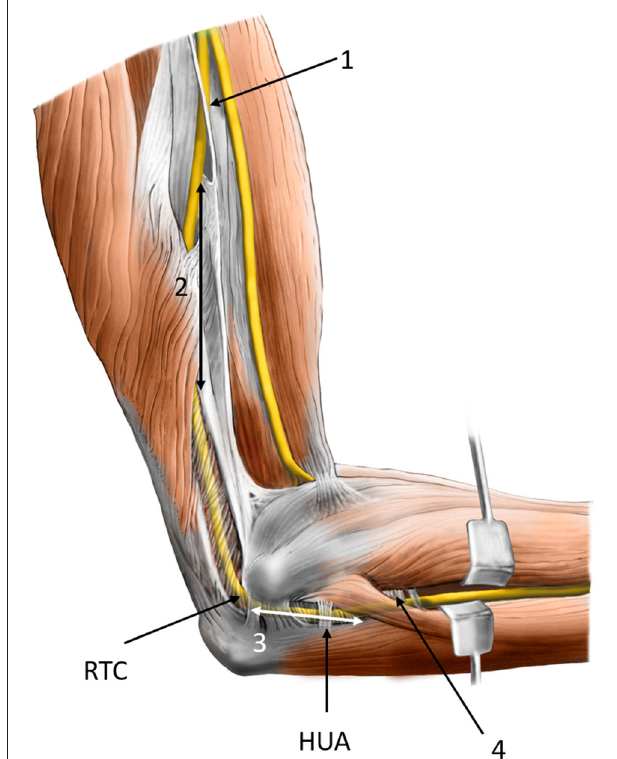
FIGURE 1 | Possible sites of compression of the ulnar nerve at and around the elbow: (1) the medial intermuscular septum of the arm, (2) arcade of Struthers, (3) cubital tunnel, and (4) connective tissue between flexor carpi ulnaris and flexor digitorum superficialis muscles. RTC, retroepicondylar groove; HUA, humeroulnar aponeurotic